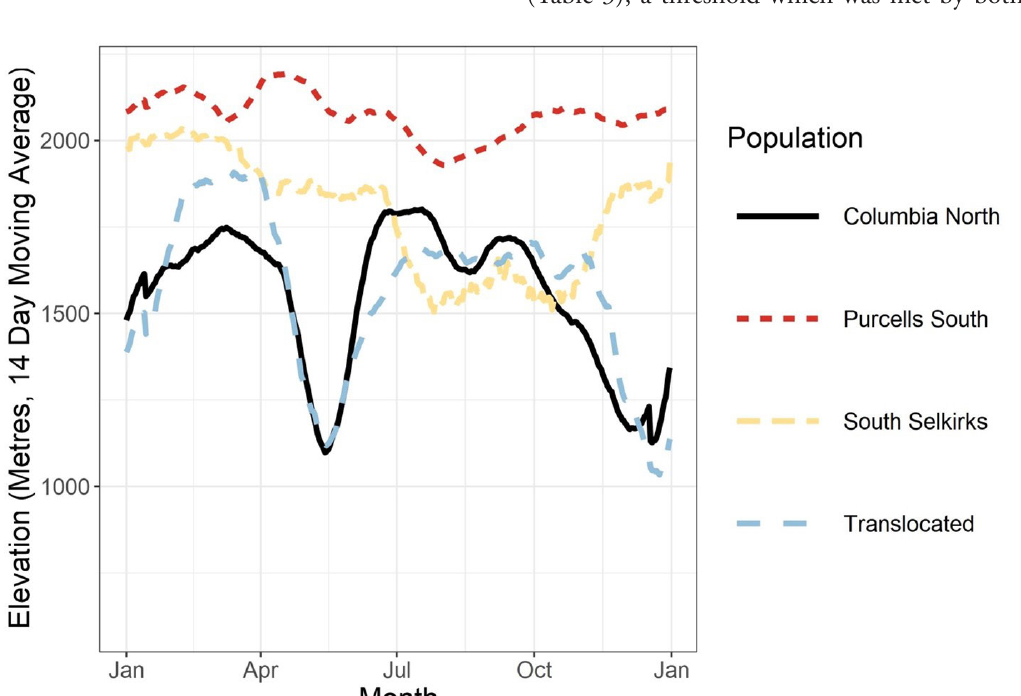
Figure 1. Seasonal elevation profiles for the Purcells-South, South Selkirks and Columbia North caribou popula- tions in southeastern British Columbia. Translocated caribou were moved into the Columbia North range from the Purcells-South and South Selkirks ranges and immediately adopted novel elevational strategies that closely matched of the resident Columbia North